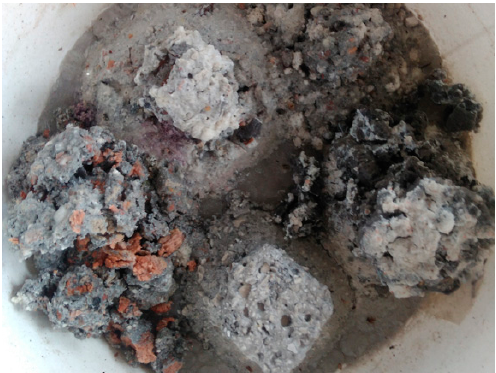
Figure 11. Samples of composites after 240 days of saturation in the solution.